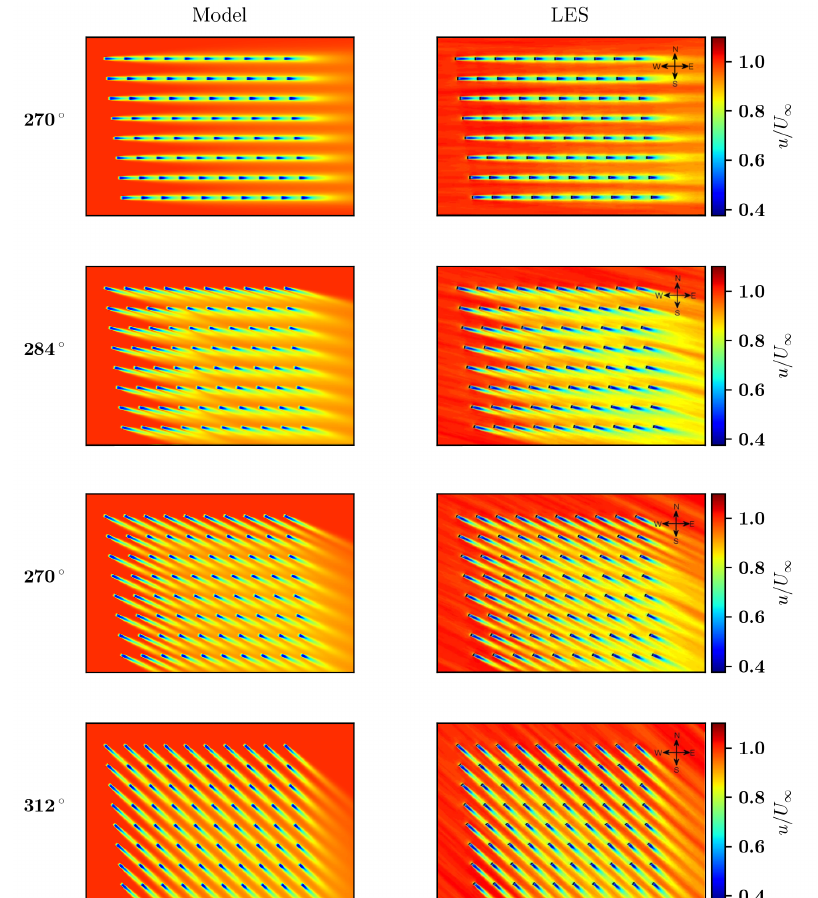
Figure 5. Velocity field of Horns Rev wind farm at various wind angles. Results compare the current model (left) to time-averaged LES velocity fields (right). LES fields reproduced from [44], which is licensed